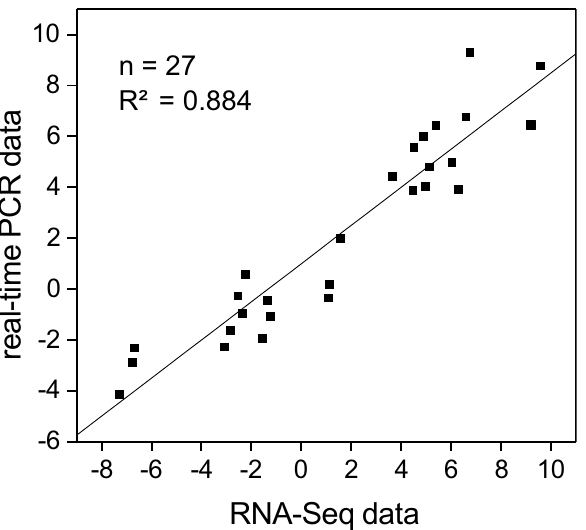
Figure 7. Validation of Illumina RNA-Seq results by real-time RT-qPCR assays for 10 pepper genes. Linear regression coefficient was calculated between gene expression levels obtained from RNA-Seq and RT-qPCR. Fold-changes in the expression of genes are shown on log2 scale at both